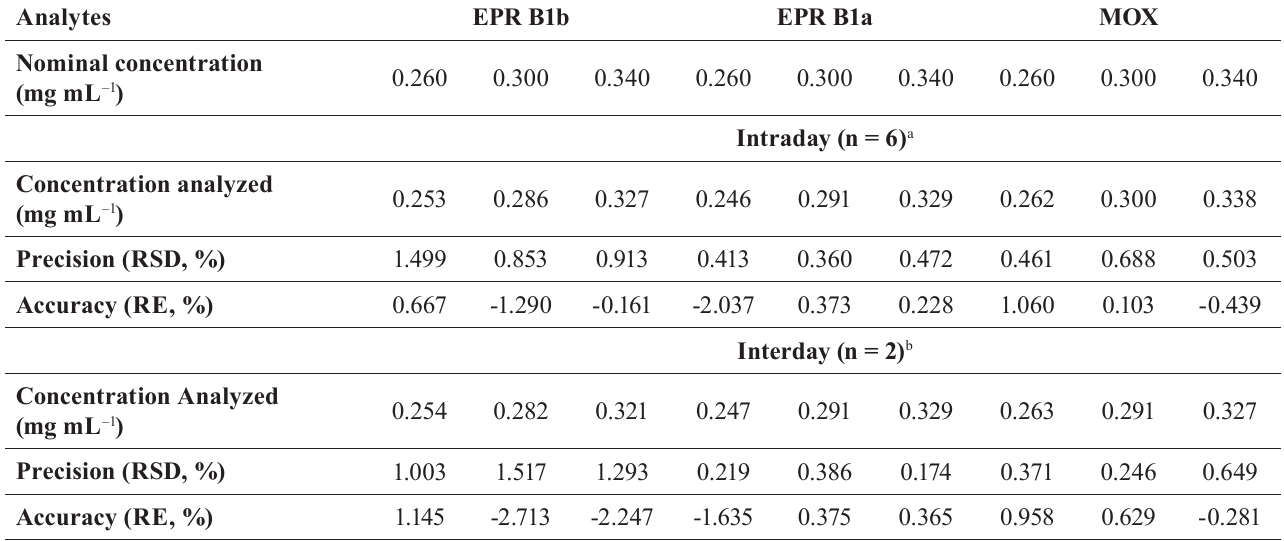
TABLE V - M edium values of the precision and accuracy for EPR B1b and B1a and MOX analysis